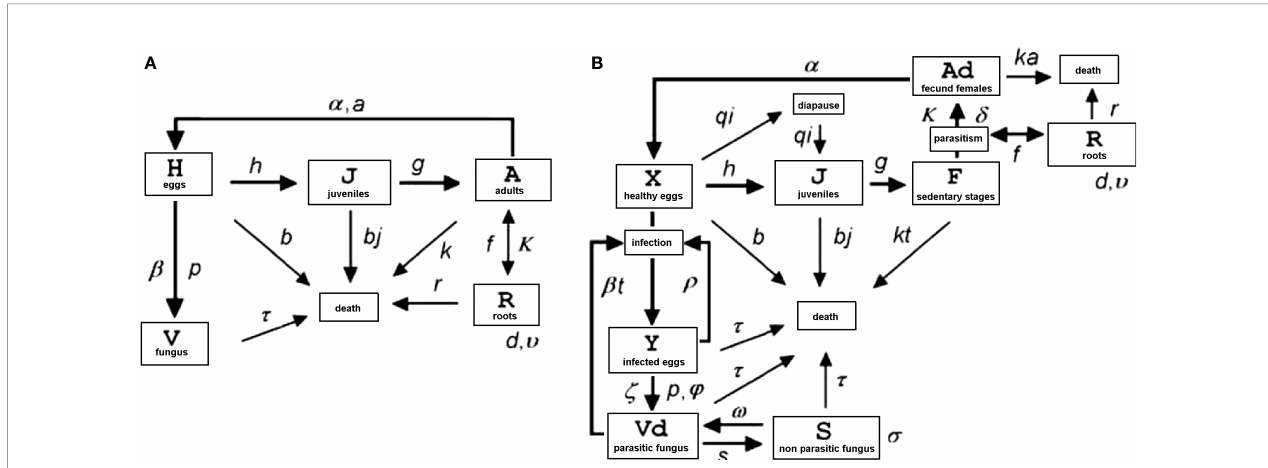
FIGURE 1 | Diagrams of models GPNR (A) and GPNRd (B) . Both models describe the relationships among the root-knot nematode Meloidogyne incognita , the parasitic fungus Pochonia chlamydosporia , and the host plant root in a simulated rhizosphere microcosm (for variables, constants, and dimensions see Table 1